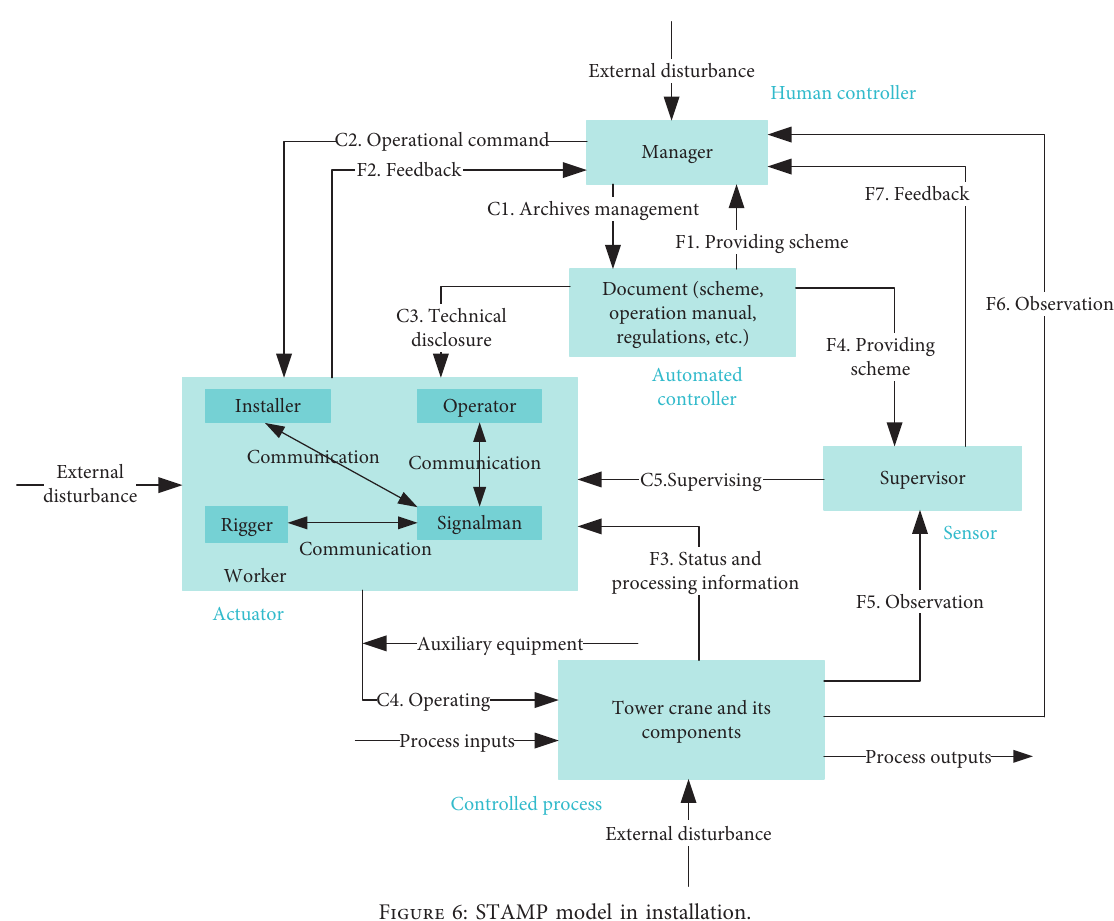
Figure 6: STAMP model in